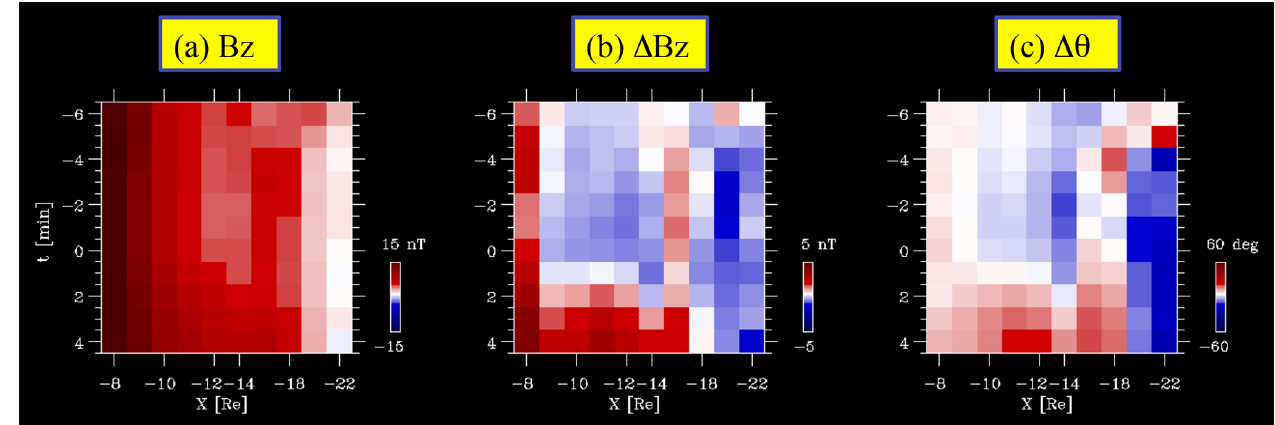
Fig. 7. As for Fig. 6, but for (a) the northward magnetic field, B Z ; (b) its deviation, 1B Z ; and (c) the change in elevation angle, 1θ , in the equatorial